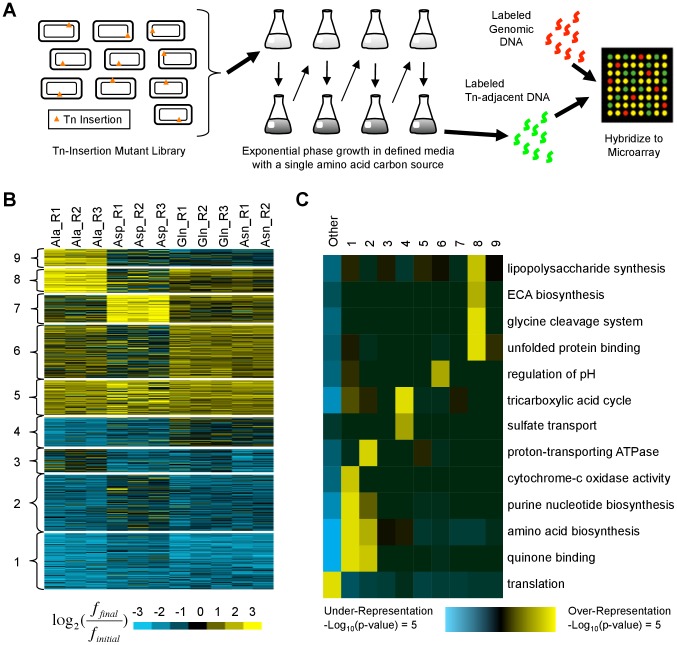
Identification and characterization of transposon insertion locations that alter fitness in single amino acid media.(A) A library of ∼500,000 independent transposon insertion mutants [21] was grown for ∼20 generations in defined media with a single amino acid carbon source. Serial dilutions were used to keep the cultures in exponential phase. To characterize the distribution of transposon insertion locations in the population, DNA adjacent to the transposons was amplified, labeled, and hybridized to a custom ORF microarray. (B) K-means clustering was used to organize the fitness profiles of 809 genes in whose vicinity transposon insertions significantly altered fitness in at least one media (see Materials and Methods). Each row represents a gene; each column contains data from a different biological replicate. Values compare the fraction of mutants with transposon insertions in or near each gene before (finitial) and after (ffinal) growth in single amino acid media. Yellow (blue) indicates an increase (decrease). (C) Shown are functional enrichments and depletions based on Gene Ontology annotations that iPAGE [24] identified in the clusters from (B) and the genes not in any cluster (‘Other’). ECA: enterobacterial common antigen.